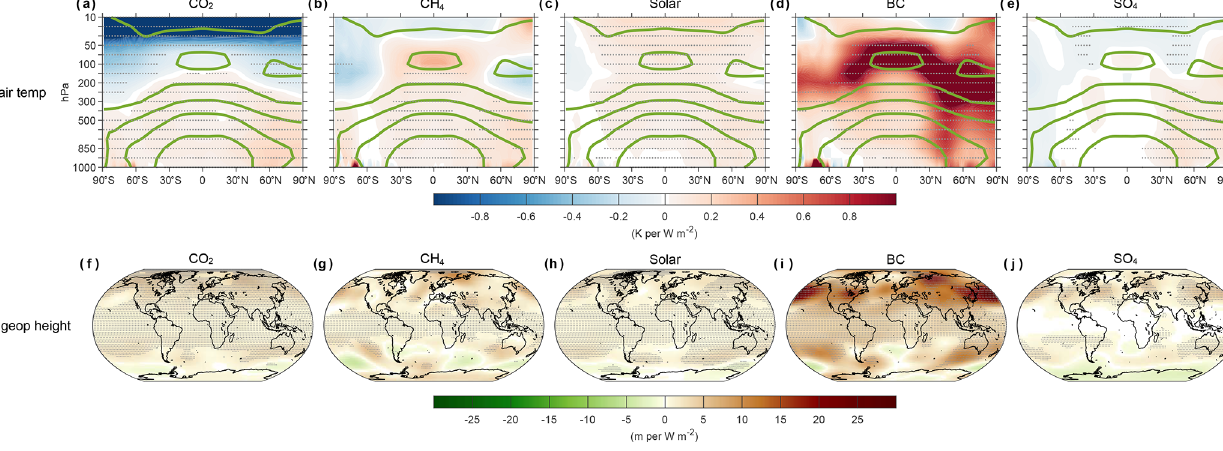
Figure 7. MMM changes for zonal atmospheric temperature (a–e) and geopotential height of 500hPa (f–j) per unit of global TOA forcing. The thick green lines in the upper row are the climatology temperature in the control simulation. Grey dots indicate that the MMM changes are significant at a p value of